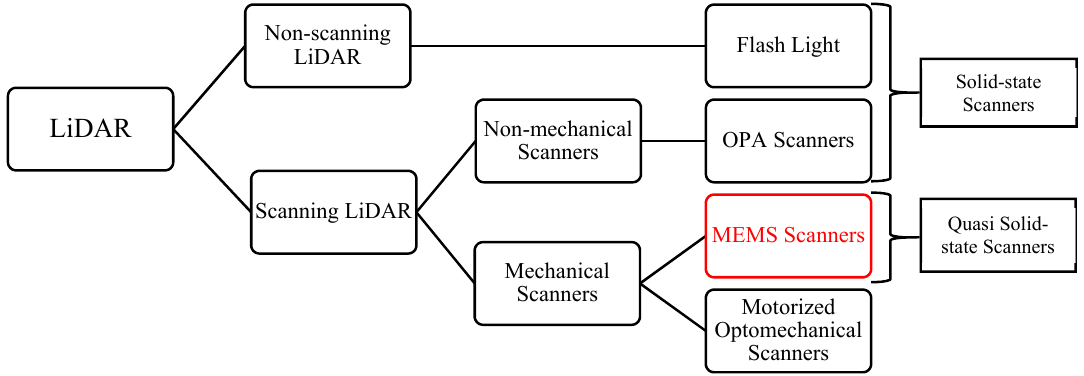
Figure 1. Di ff erent types of LiDAR scanners. Figure 1. Different types of LiDAR Figure 1. Different types of LiDAR scanners.